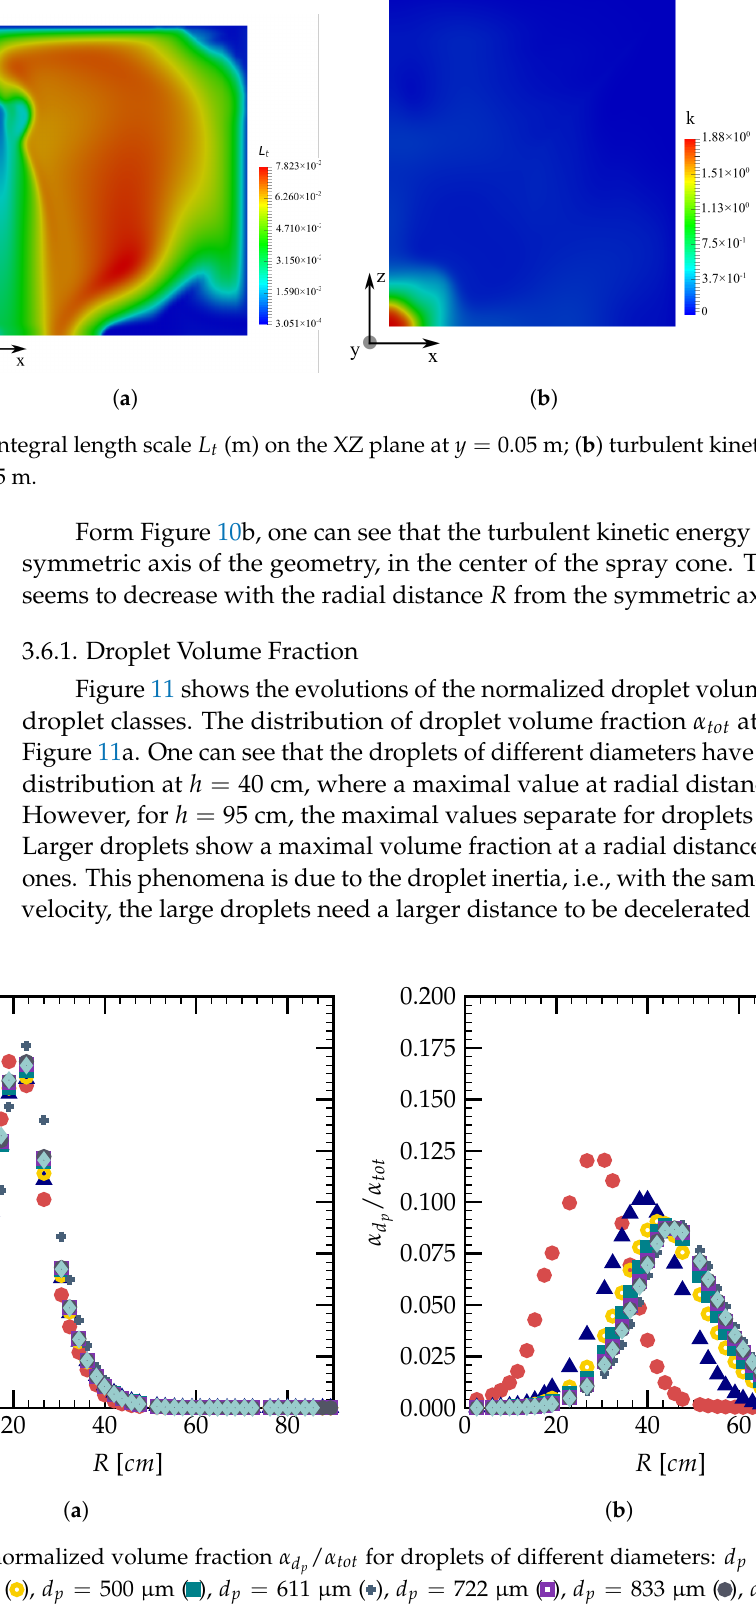
/ α tot for droplets of different diameters: d p = 166 µ m ( ), d p = p